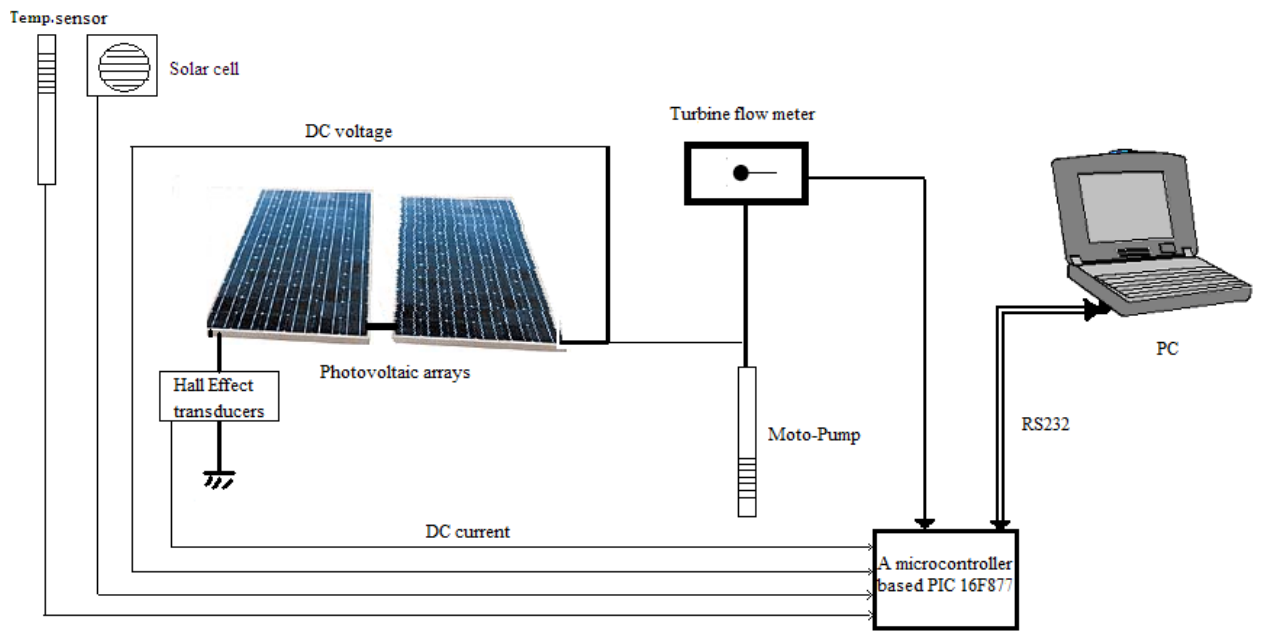
Figure 6. Schema of system